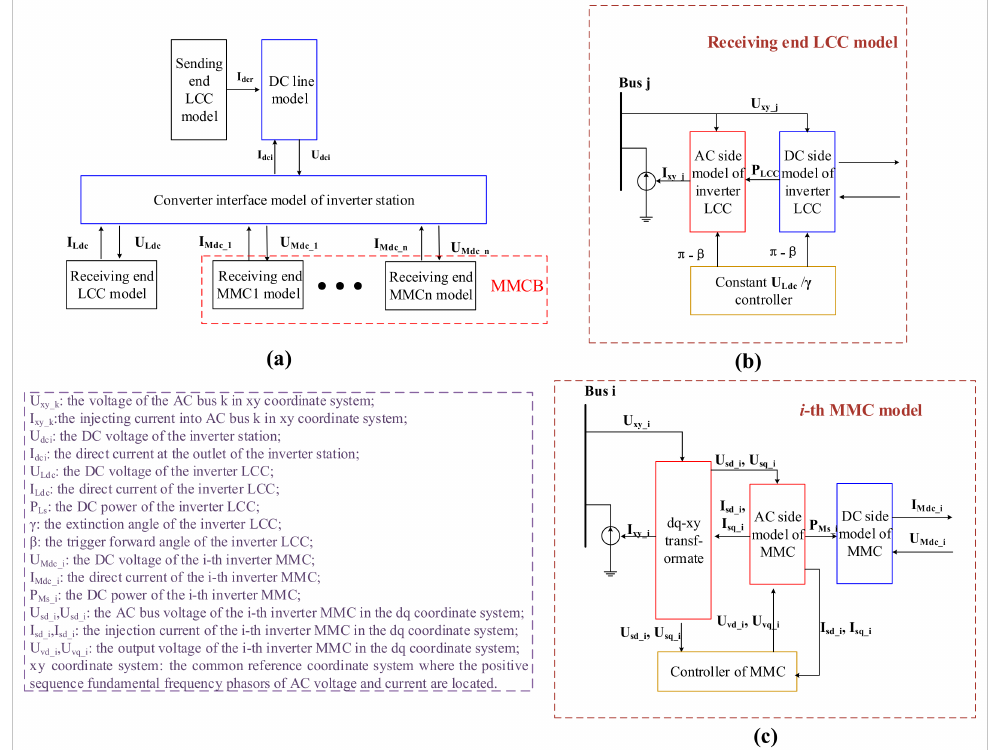
Figure 2. The whole structure of the electromechanical model of the decentralized hybrid High Voltage Direct Current (HVDC) system. ( a ) The diagrammatic sketch of the whole system. ( b ) The detailed structure of the receiving end LCC. ( c ) The detailed structure of the